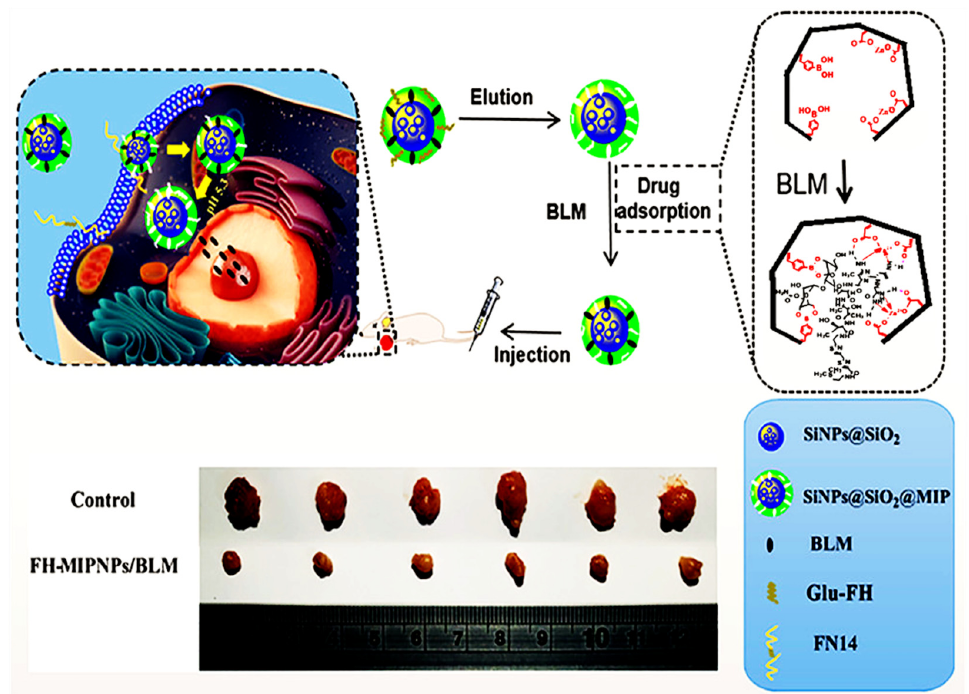
Figure 11. General illustration of preparation and application of silane-modified MIP@SiO 2 . Repro- duced with permission from [90].